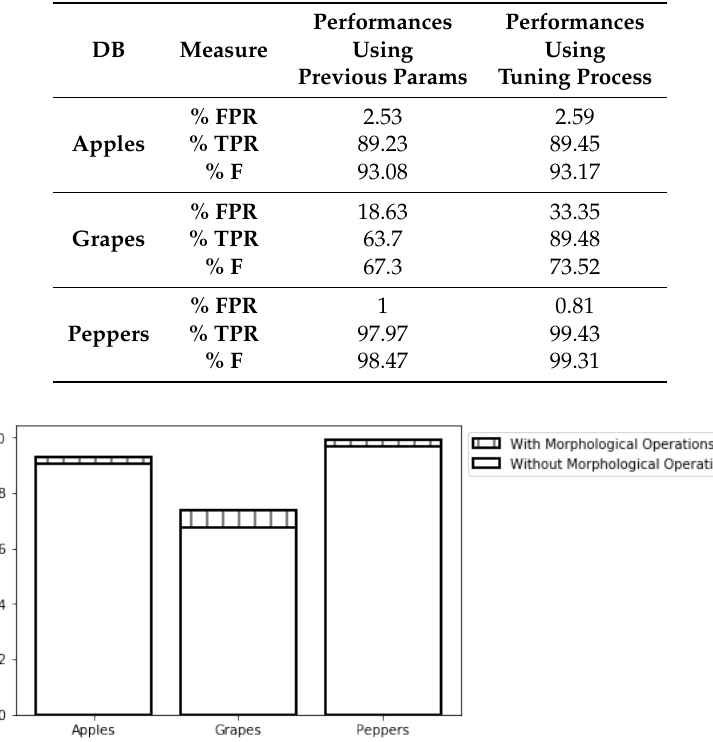
Table 8. Parameter tuning contribution to algorithm performances.